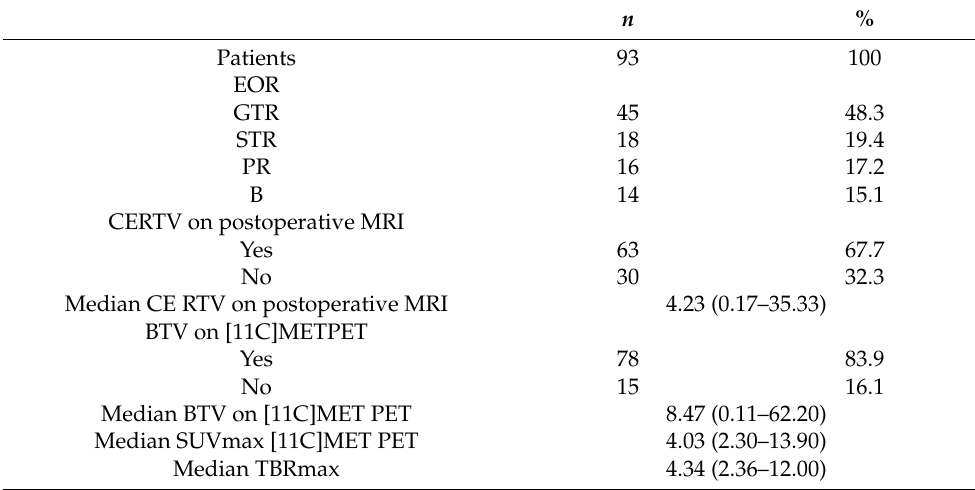
Table 2. Extent of resection (EOR), contrast-enhanced residual tumor volume (CERTV) on postopera- tive MRI and on simulation [11C]METPET characteristics for the whole